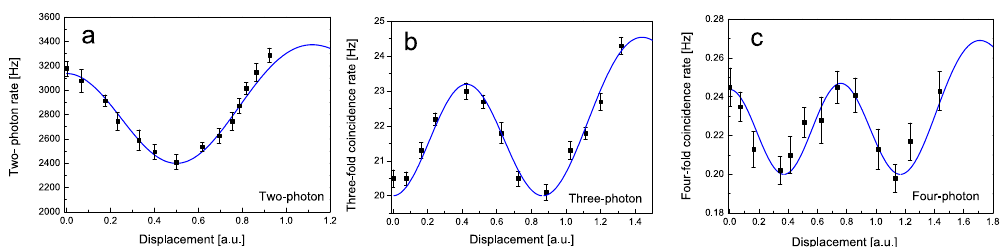
Figure 5. Experimental results: Coincidence measurements demonstrating obtaining N-photon probability for N = 2, 3 and 4 with no background subtraction. Error bar indicate standard deviation for five measurements. Solid curves are obtained using analytical